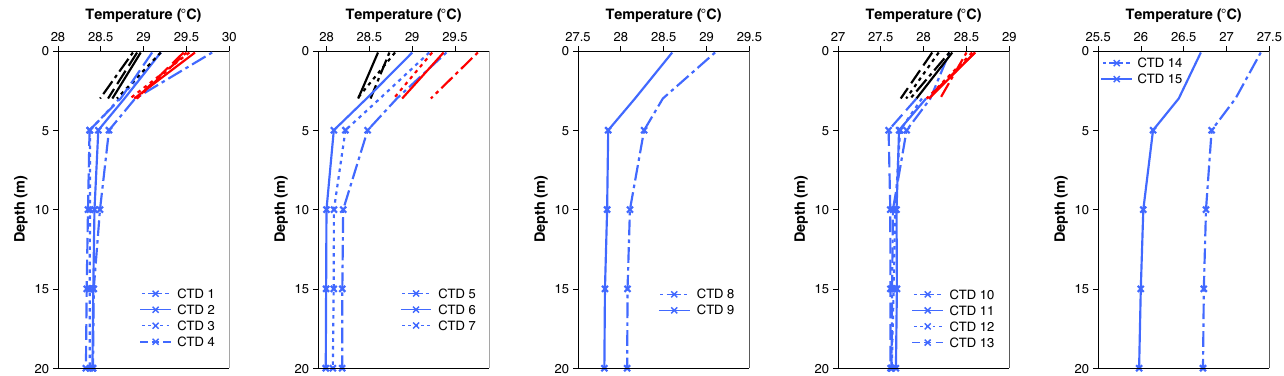
Fig. 7. Temperature structure of the upper 20m in various current regimes along the cruise transect: (a) the weak and (b) moderate branches of the South Equatorial Current (SEC), (c) the South Equatorial Countercurrent (SECC), (d) the strong branch of the SEC and (e) the equatorial cold tongue. The blue lines are temperature profiles corresponding to individual CTD casts. Temperatures at 5, 10, 15 and 20m are from CTD (indicated by the crosses) while those at 0.1 and 3m are from composite bucket SST and thermosalinograph, respectively. The bucket measurements were obtained within 2h and 15km of each respective CTD cast. Bucket temperatures are not plotted for casts 11–13 since they are unlikely to be representative of conditions at the time of the respective CTD cast (they were obtained at 12:00 or 13:00LT whereas the CTD casts were conducted between 10:00 and 11:00LT). The remaining bucket temperatures will be in error by ∼ 0.1 ◦ C or less due to such timing differences. All casts were taken between 9:00 and 12:00LT, except CTD-1 which was taken around 15:30–16:00LT. Cast numbers correspond to those on Fig. 1. The red and black lines characterise the daily extremes of the upper 3m temperature profile on the local day of the corresponding CTD cast. They are respectively defined from maximum and minimum 3-hourly average 3m temperatures, and corresponding 3-hourly average composite bucket temperatures. They are not plotted in the panels for the SECC and cold tongue, where diurnal cycles were masked by transit through strong meridional